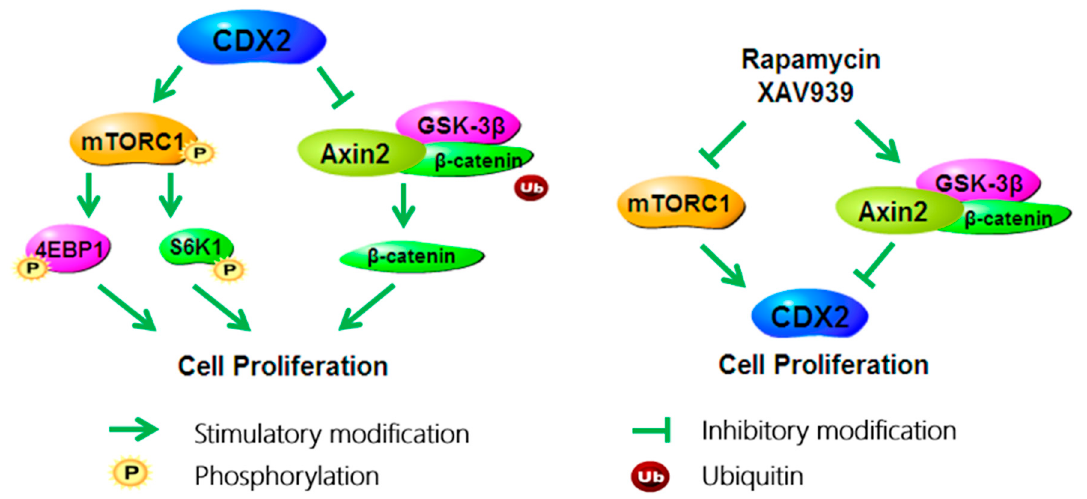
Figure 7. In IPEC-J2 cells, CDX2 promotes cell proliferation via activating the mTORC1 and Wnt/ β - catenin pathways; specific antagonists of the mTORC1 and Wnt/ β -catenin pathways, namely rapamycin or XAV939 respectively, decrease cell proliferation and inhibit both pathways